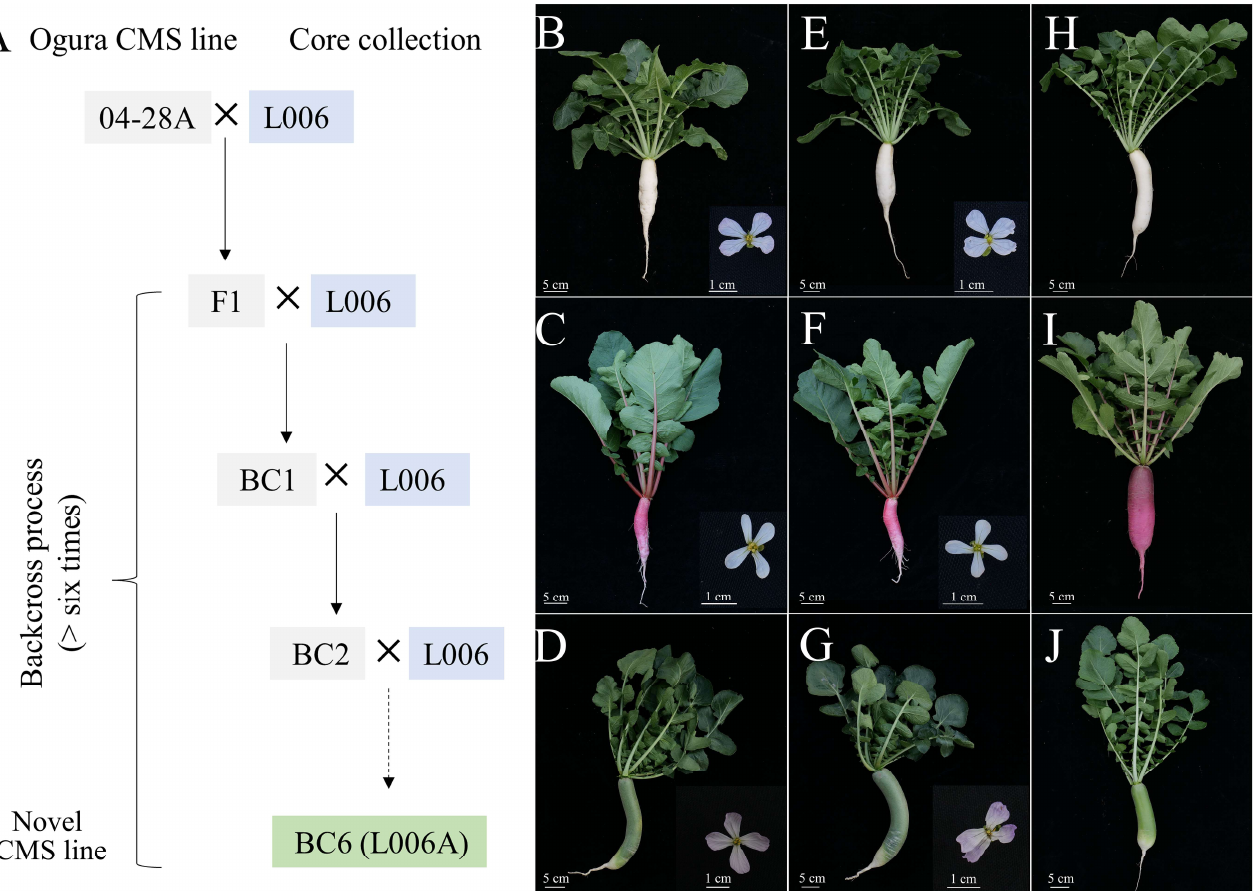
Figure 5. Utilization of three selected core germplasm collections in this study. ( A ) Construction of novel Ogura CMS line L006A. The morphology of the whole plant and its flowers of L006 ( B ), L009 ( C ), L012 ( D ), L006A ( E ), L009 ( F ), and L012 ( G ). The new radish cultivars CR Chuyu No.2 ( H ), ZMR ( I ), and Chucui No.2 ( J ).